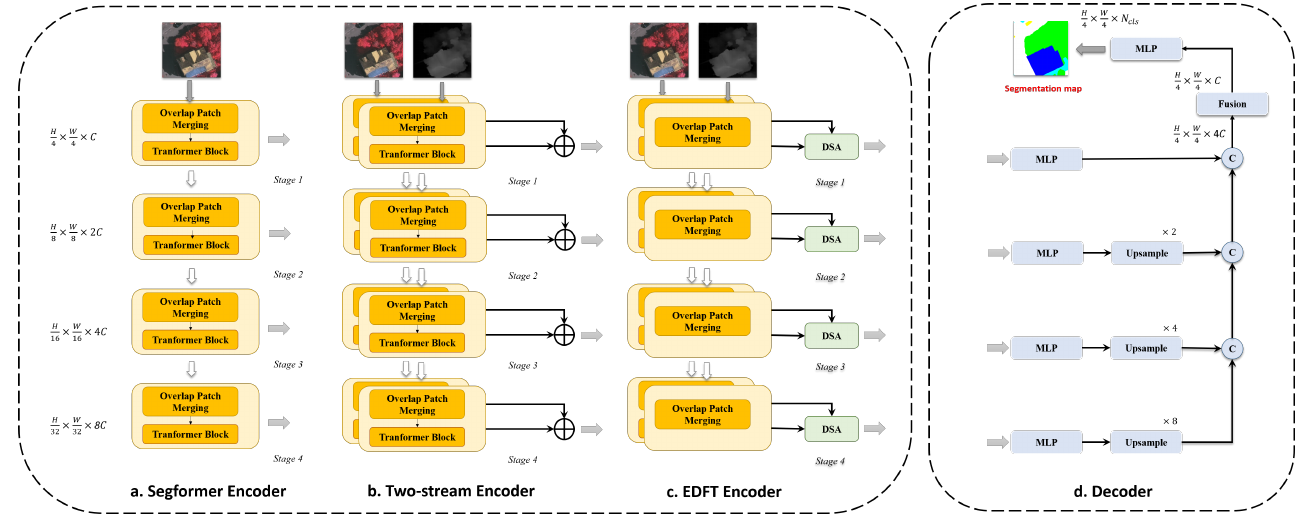
Figure 1. Connection between Segformer and our method EDFT. There are three networks depicted in Section 3, differing in the encoder structure. While Segformer only handles color input, the other two networks are designed for RGB-D